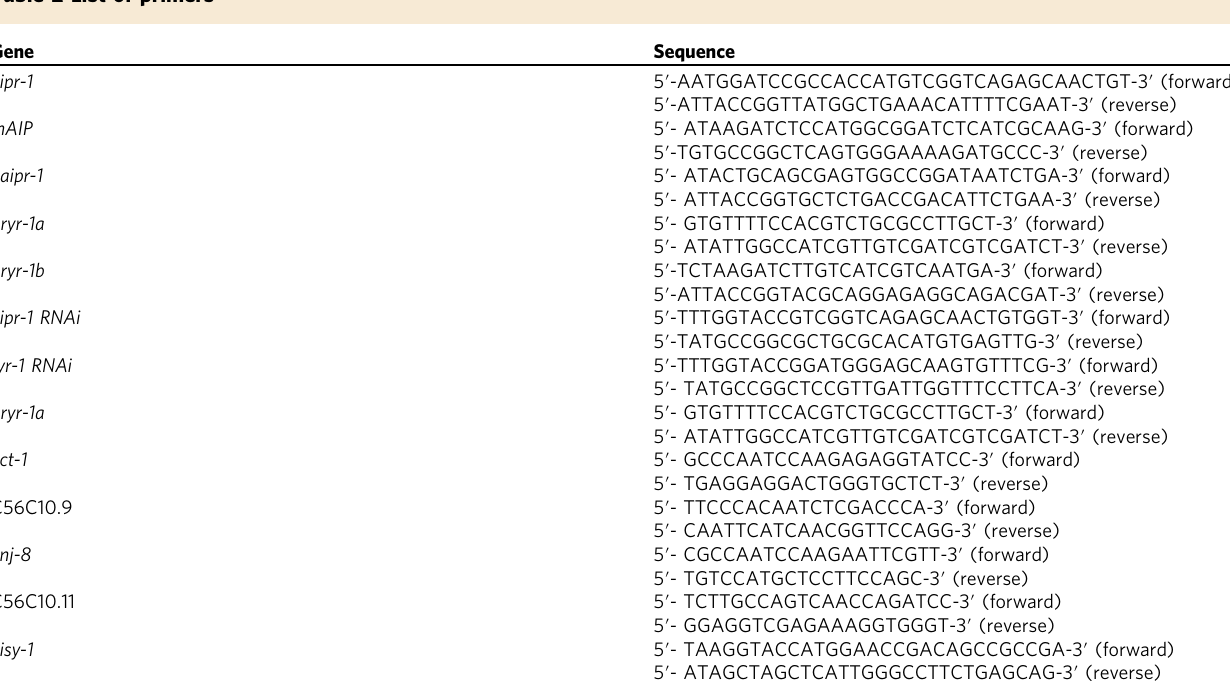
Table 2 List of primers Gene